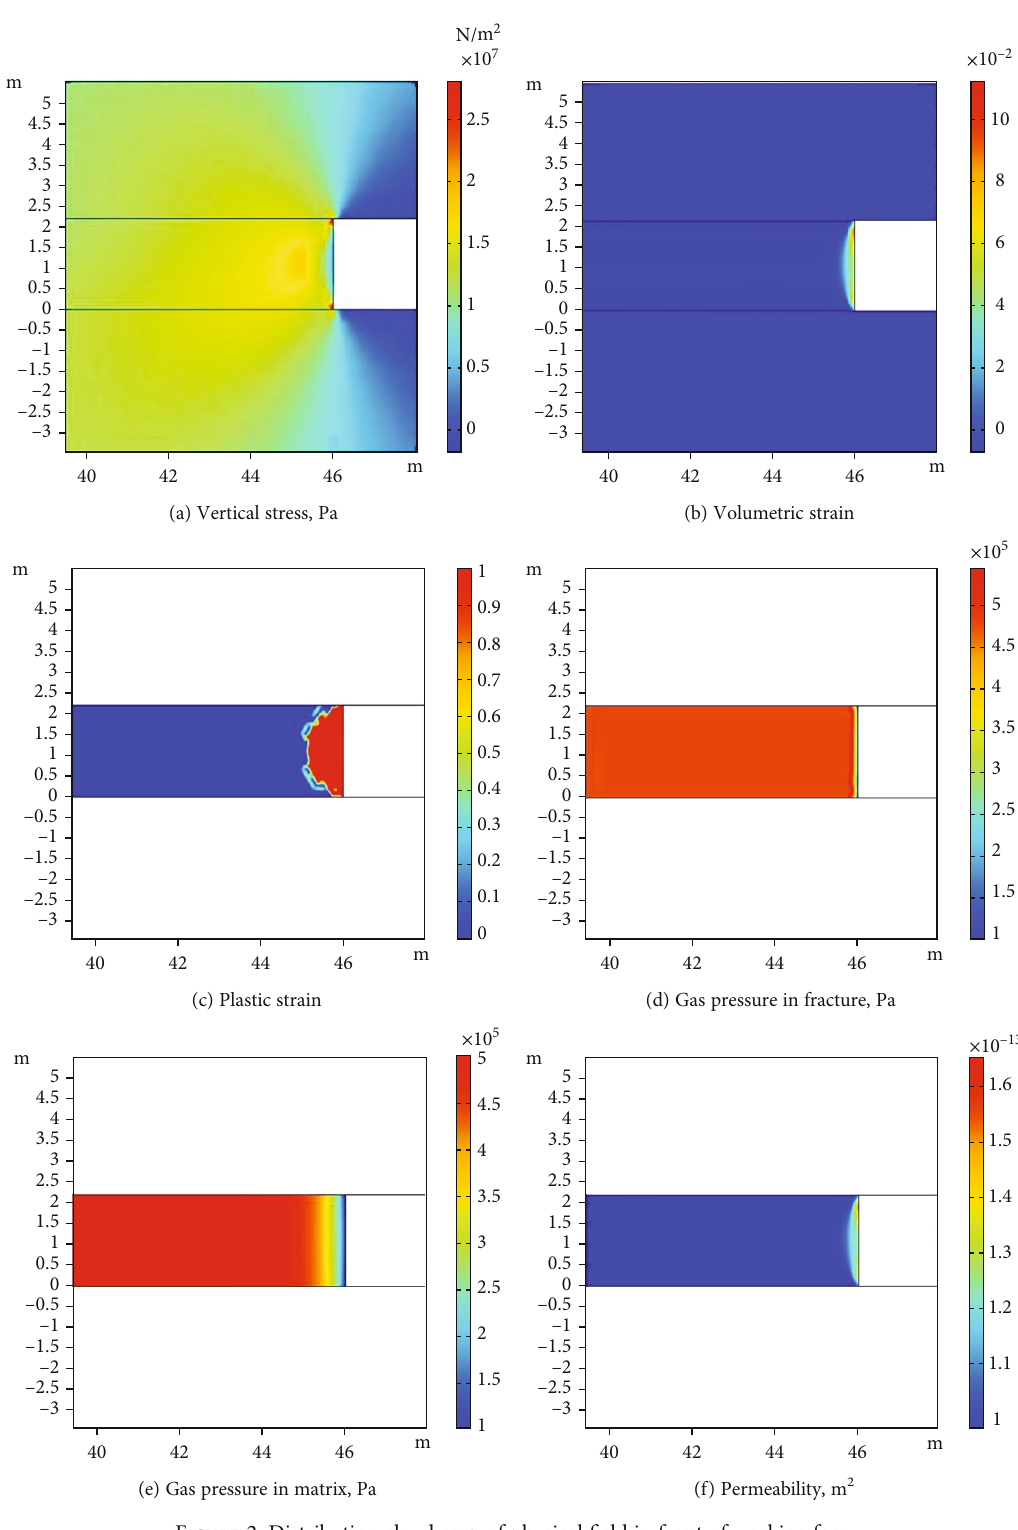
Figure 2: Distribution cloud map of physical fi eld in front of working